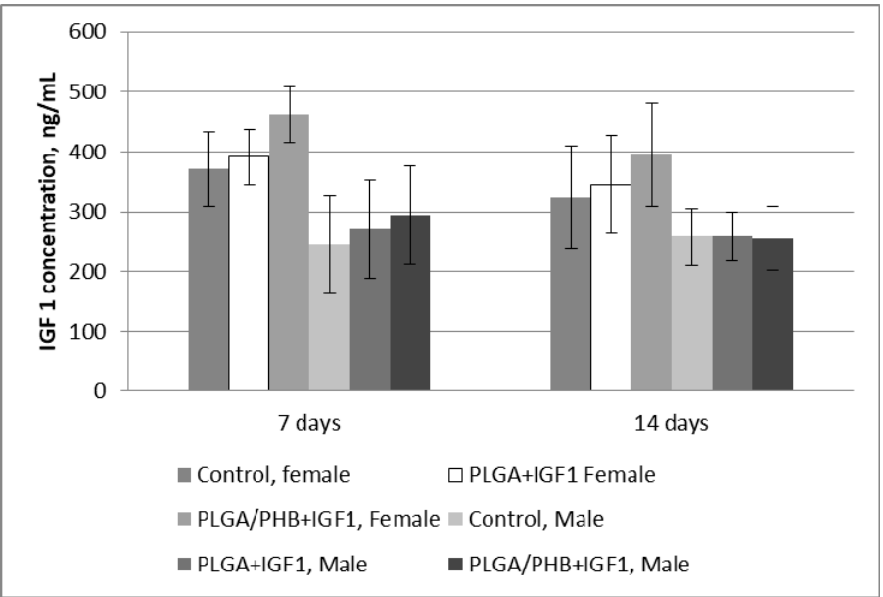
Figure 16. Insulin-like growth factor 1 (IGF1) concentration of in blood after 7 and 14 days from implantation.